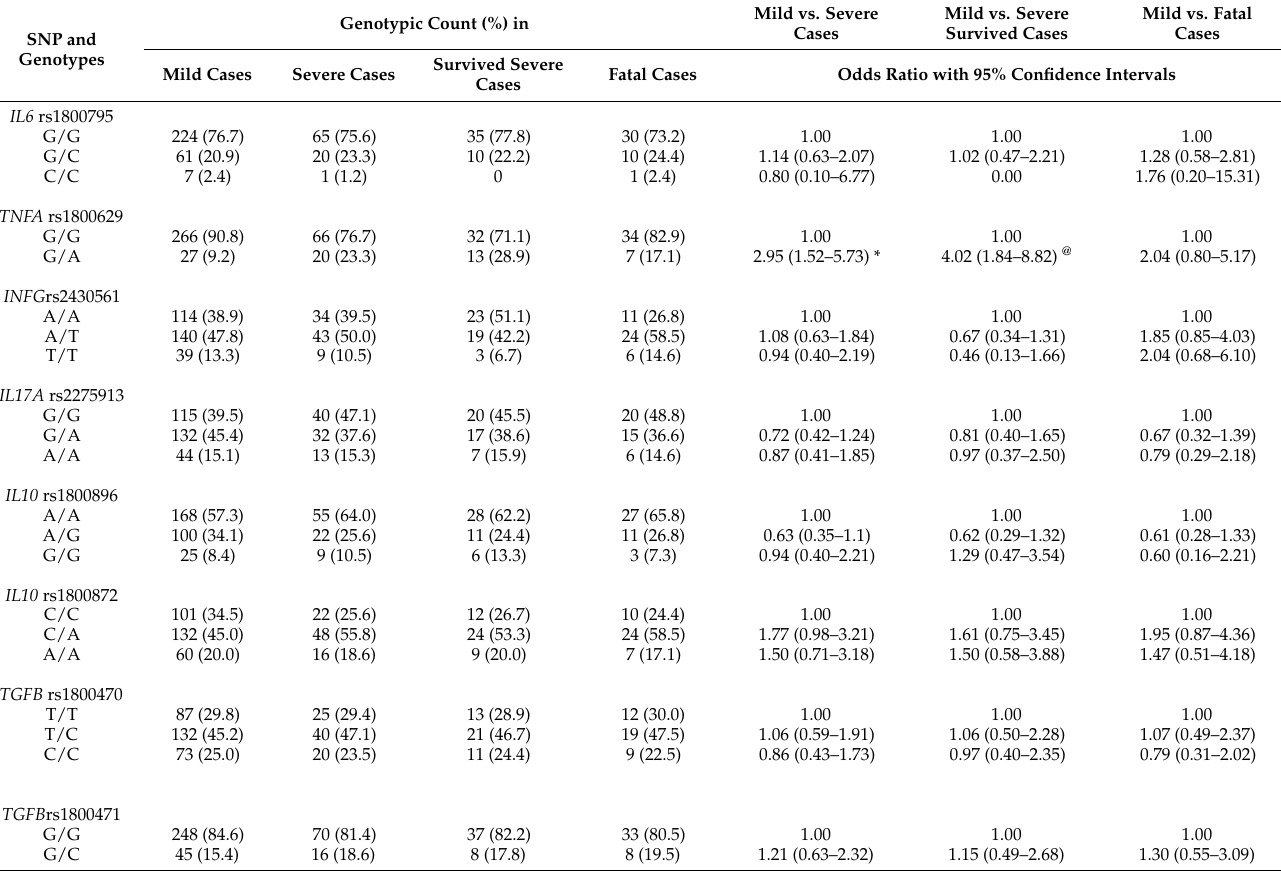
Comparison of genotype frequencies of different SNPs among the study groups revealed that the frequency of TNFA rs1800629 G/A allele was significantly higher in severe cases and survived severe cases group compared to that of those with mild infection (OR with 95% for mild vs. severe cases 2.95 (1.52–5.73); mild vs. survived severe cases 4.02 (1.84–8.82)). Though the frequency of TNFA rs1800629 G/A allele was higher in fatal cases compared to mild cases, it was not statistically significant. The genotype frequencies of other SNPs were comparable between the influenza A(H1N1)pdm09-infected patient groups (Table 3). Table 3. Percent genotype frequencies of cytokine gene polymorphisms in Influenza A(H1N1)pdm09 patient groups. Genotypic Count (%) SNP and Genotypes